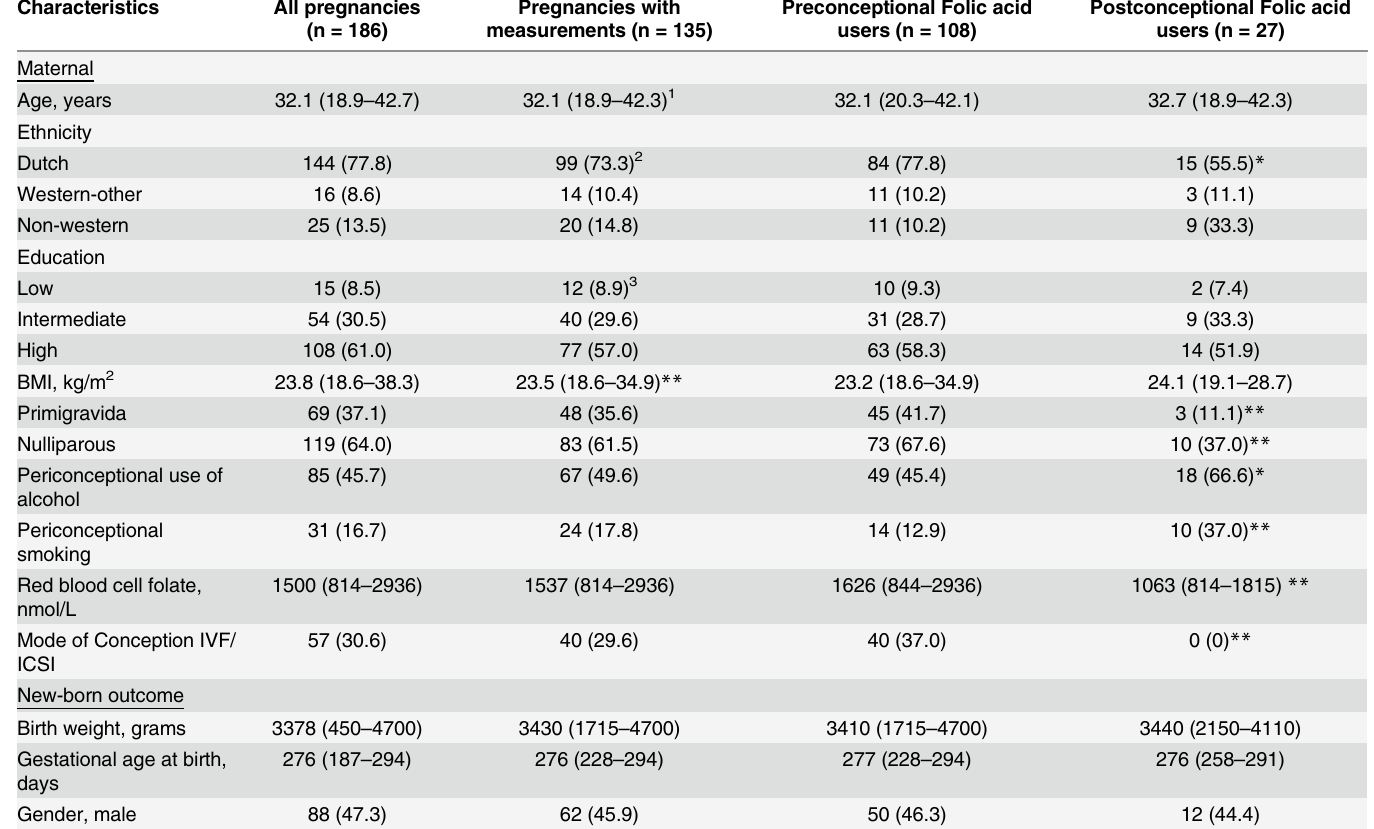
Table 1. General Characteristics of the study